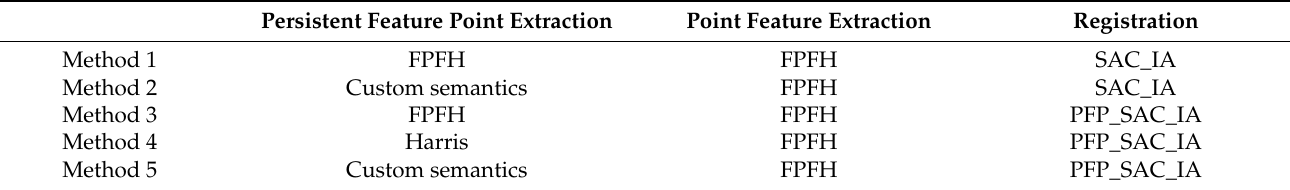
Table 3. Comparison of methods for ablation studies.